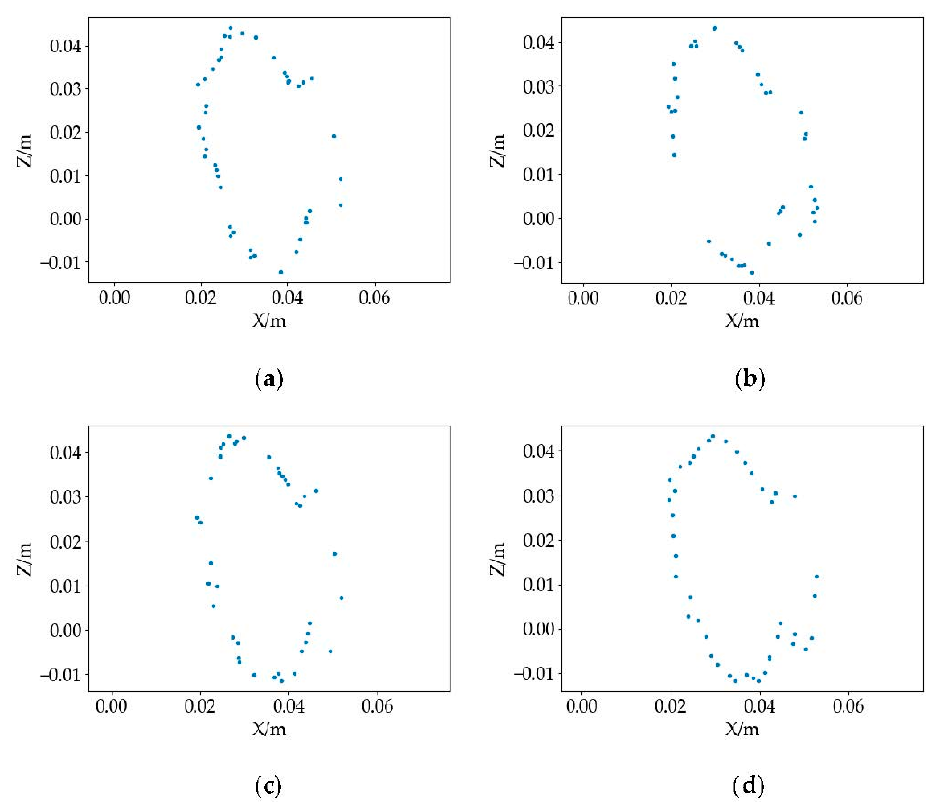
Figure 5. Contour point cloud projection: ( a ) curvature down-sampling; ( b ) random down-sample; ( c ) uniform down-sample; and ( d ) voxel down-sample.